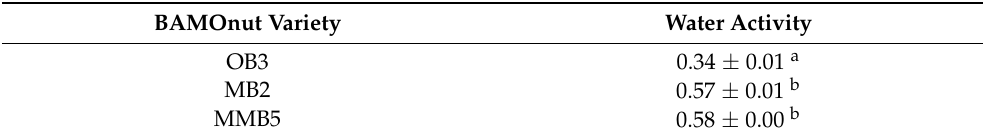
Table 5. Water activity of Bambara groundnut- Moringa oleifera snack